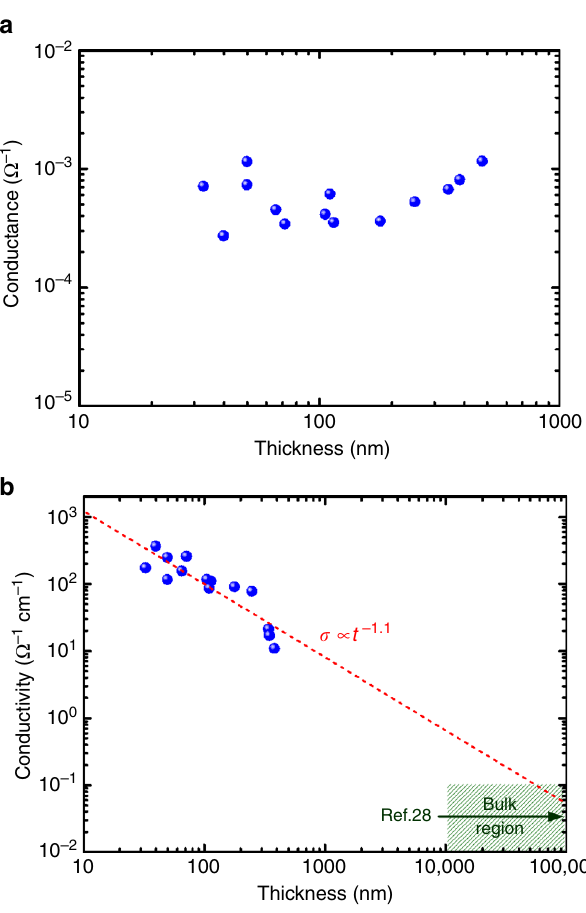
Fig. 2 Thickness-dependent conductivity in MoS 2 nano fl akes. a Linear plot of conductance versus thickness and b logarithmic plot of conductivity versus thickness for MoS 2 nano fl akes. The conductivity range of MoS 2 bulks obtained by our measurements and from ref. 28 is shown for comparison. The red dashed line is the fi tting line for the conductivity versus thickness